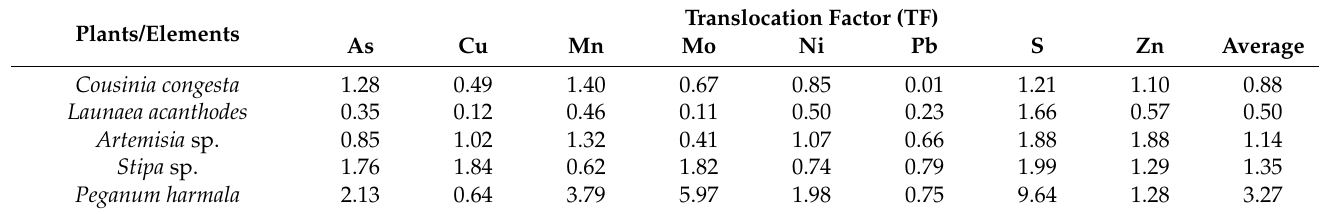
Table 6. The TF values of the sampled native plants in the most contaminated station for different